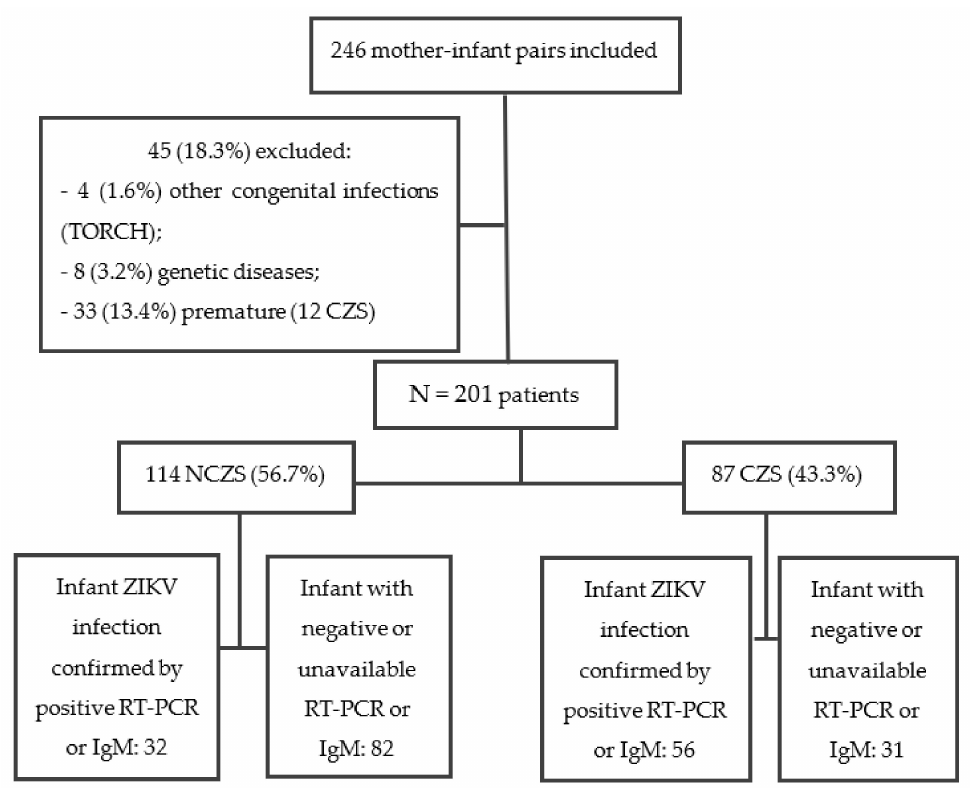
Figure 1. Flowchart of Participant Recruitment. ZIKV: zika virus; TORCH: toxoplasmosis, rubella, cy- tomegalovirus, herpes and others (HIV, syphilis); CZS: congenital zika syndrome; NCZS: not congenital zika syndrome; RT-PCR: reverse transcriptase-polymerase chain reaction; IgM: immunoglobulin